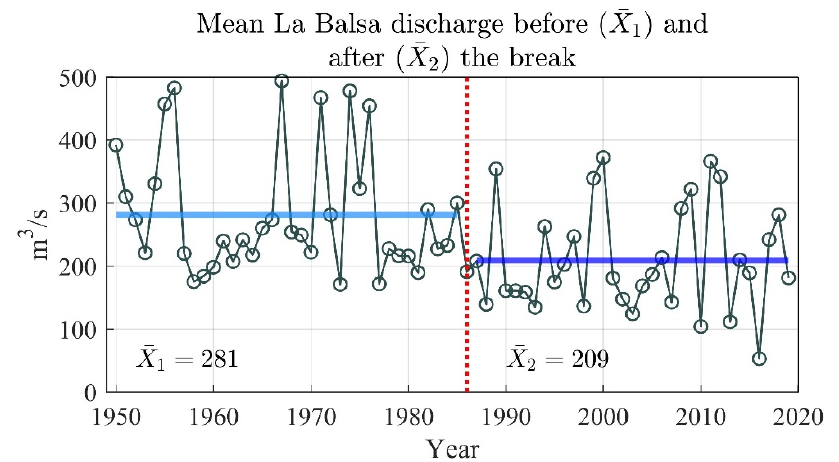
Figure 2. Mean La Balsa discharge time series from November to January (NDJ) during the 1950–2019 period (solid line). According to the Pettit test, the vertical red dashed line indicates the break year (1986), significant at the 0.05 significance level. The two horizontal lines represent the mean discharge value before ( X 1 ) and after ( X 2 ) the break.